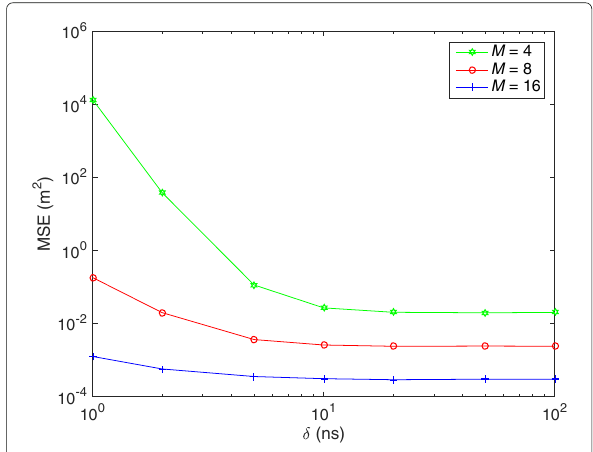
Fig. 7 Numerical result 5. MSE versus δ with M as a parameter, for B = 80 MHz, ρ = 0 dB, and N P = 10